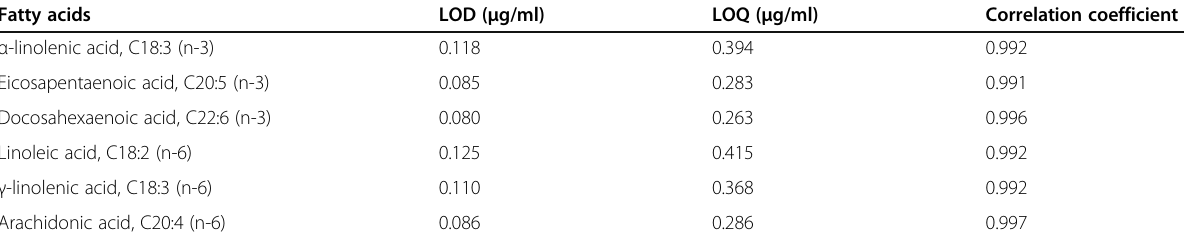
Table. 5 Detection (LOD) and quantification limits (LOQ) Fatty acids